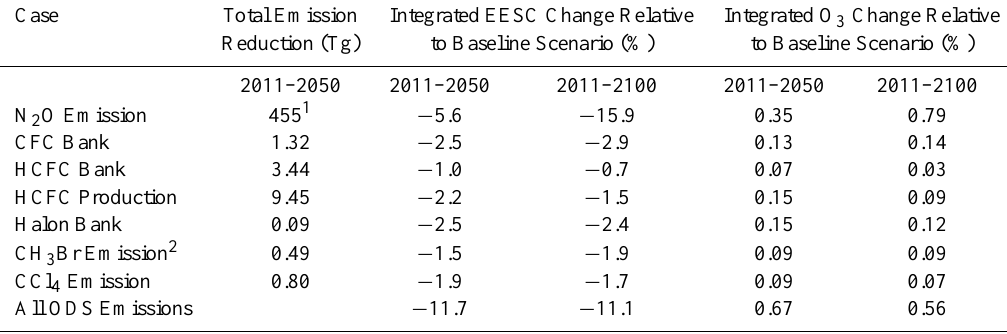
Table 1. ODS and N 2 O phaseout cases considered and their impact on integrated EESC and globally averaged total column ozone (calculated by the GSFC model) relative to the baseline case. The “Bank” cases assume the entire bank present at the beginning of 2011 is captured and destroyed, but future production continues as in the baseline case. “Production” cases assume no future production of the compound beginning in 2011, but emissions from existing banks continue. “Emissions” cases assume no anthropogenic emission from 2011 onward. The “Total Emission Reduction” column contains the cumulative emission reduction from 2011–2050 compared to the baseline case. The integrated EESC and O 3 change columns contain values for the reduction in these quantities relative to the baseline scenario for two time periods. The EESC percent changes are generally smaller than what has appeared in past ozone assessments partly because here the change is calculated relative to the entire anthropogenic EESC and because we include N 2 O contributions in EESC; in the assessments, the percentage change has been calculated relative to EESC in excess of 1980 EESC levels. If compared to EESC in excess of 1980 levels, 2011–2050 percentages here should be increased by more than a factor of 3. EESC is calculated assuming an age spectrum with a mean age and width of 3.0y and 1.5y,